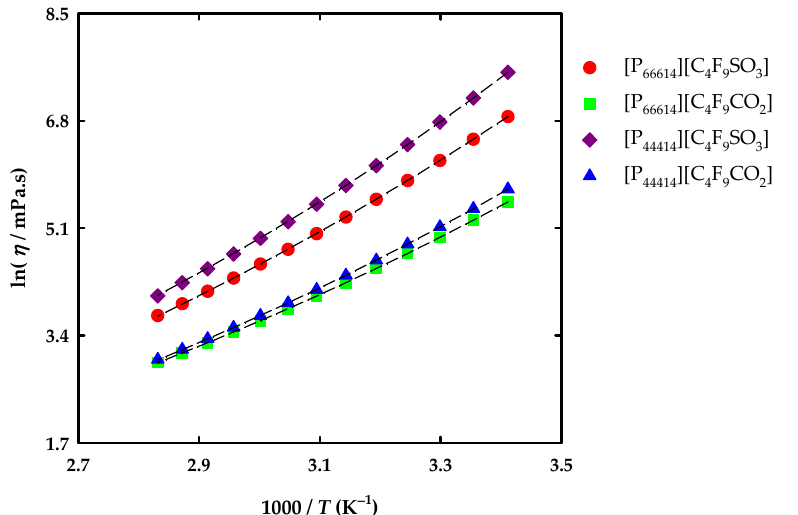
Figure 3. Arrhenius plots of the dynamic viscosity and the corresponding fitted curves for the synthesized fluorinated ionic liquids.